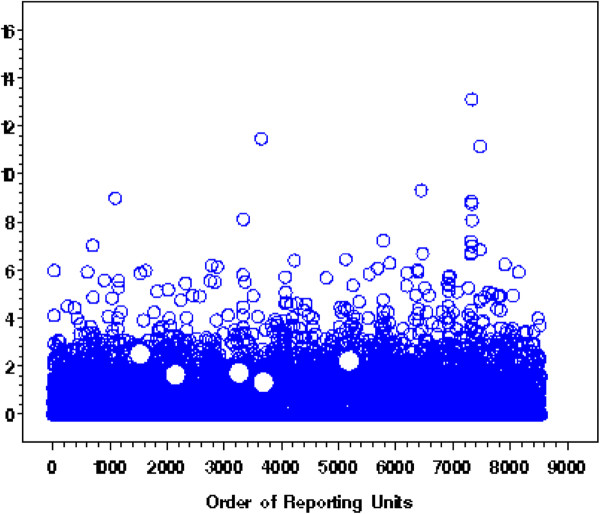
With NDNQI Injury Fall Rate for 2007 4th Quarter, the 5 flagged units for rechecking with FAST-MCD approach are all false alarms, which the IQR and MAD approach did not flag at first.